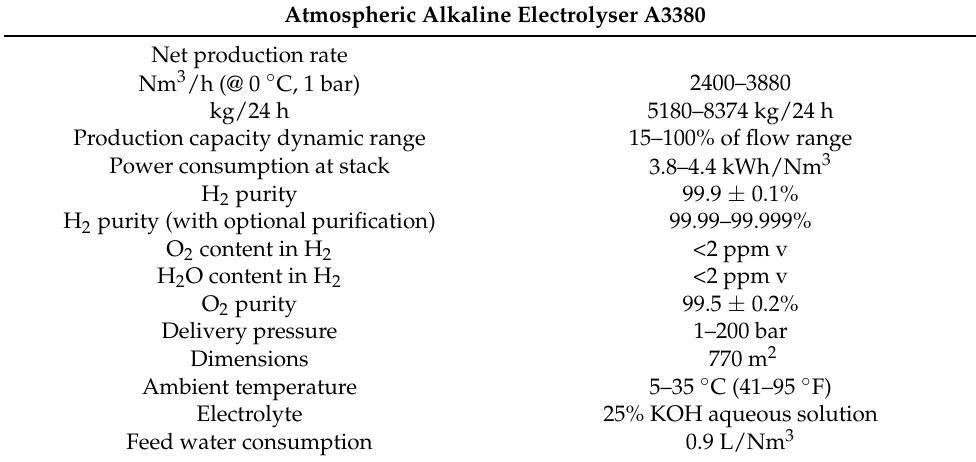
Table 4. Atmospheric Alkaline Electrolyser A3380